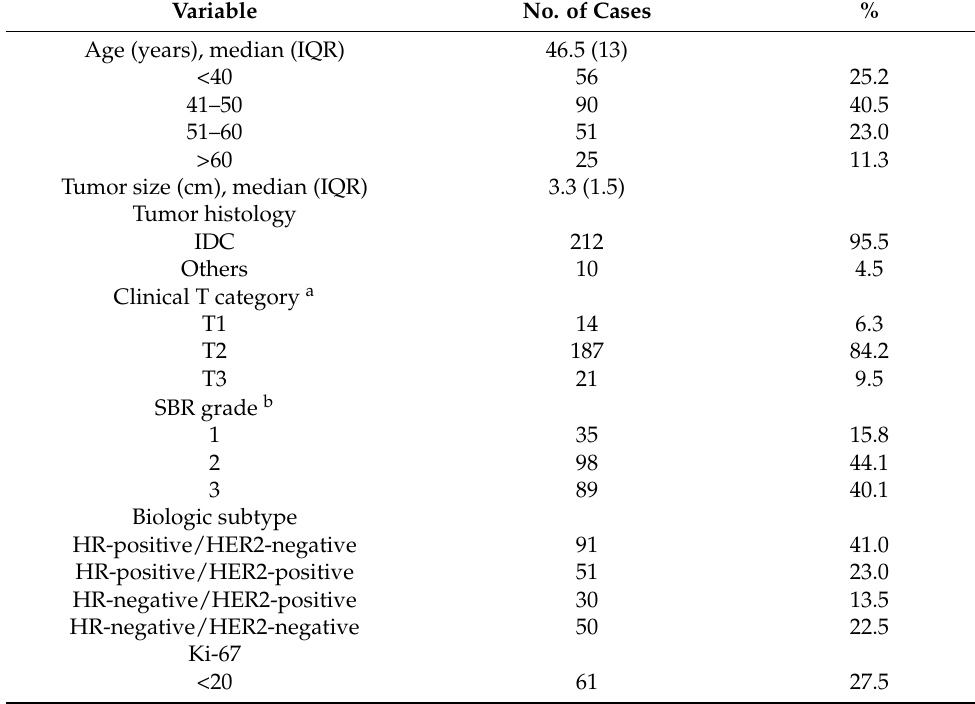
Table 1. Clinical and tumor characteristics of the whole patient cohort after